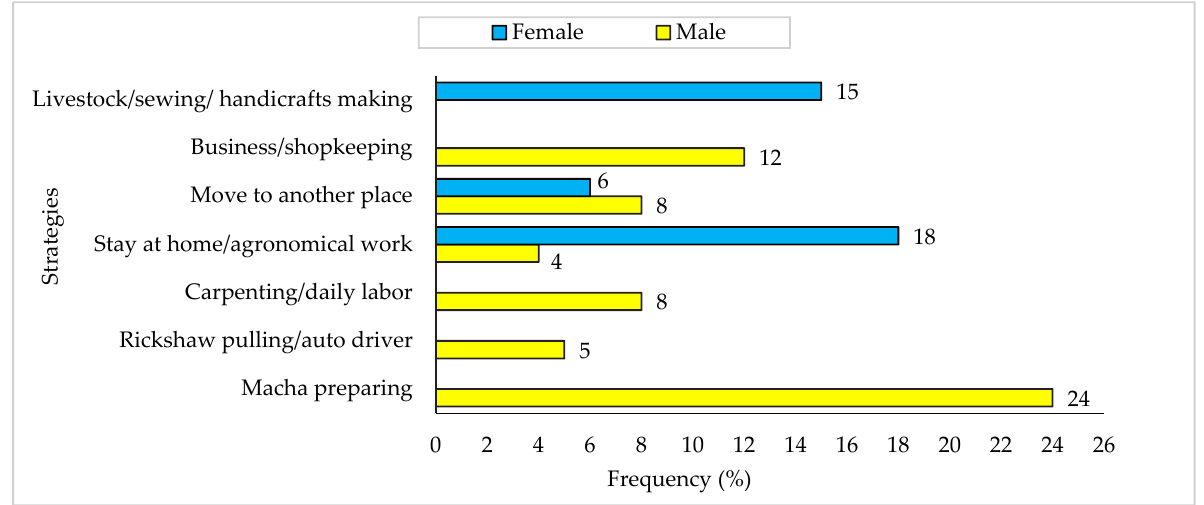
Figure 10. Coping mechanisms evolved by the communities during the off-season.